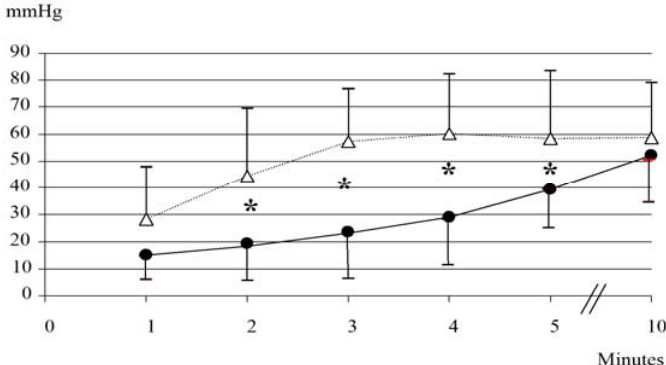
(black squares) ( top ), 2TOSCA